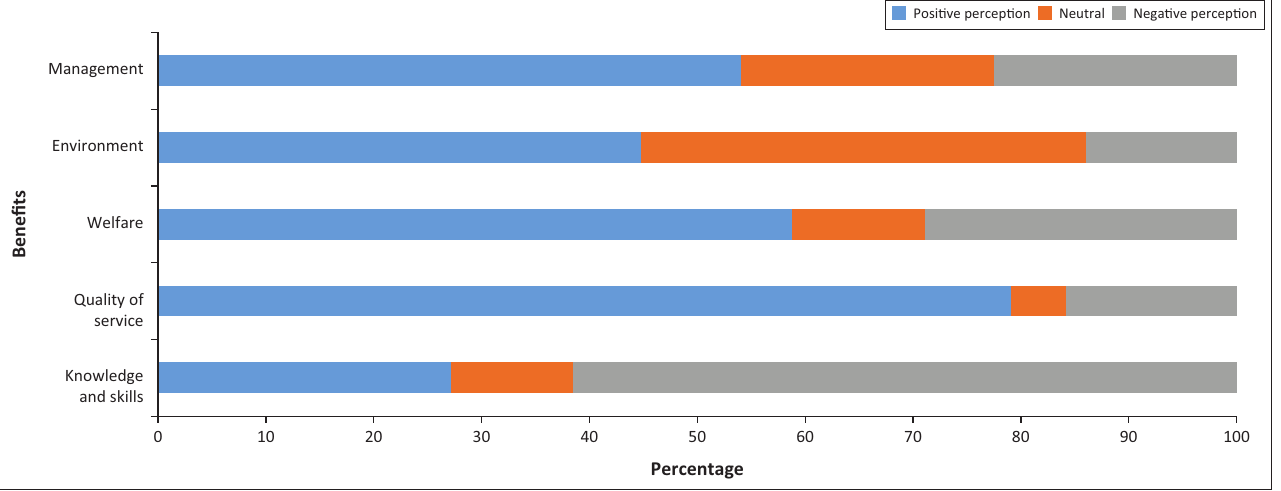
FIGURE 2: Former taxi operators’ views on benefits in regard to knowledge and skills, welfare and quality of service, environment and